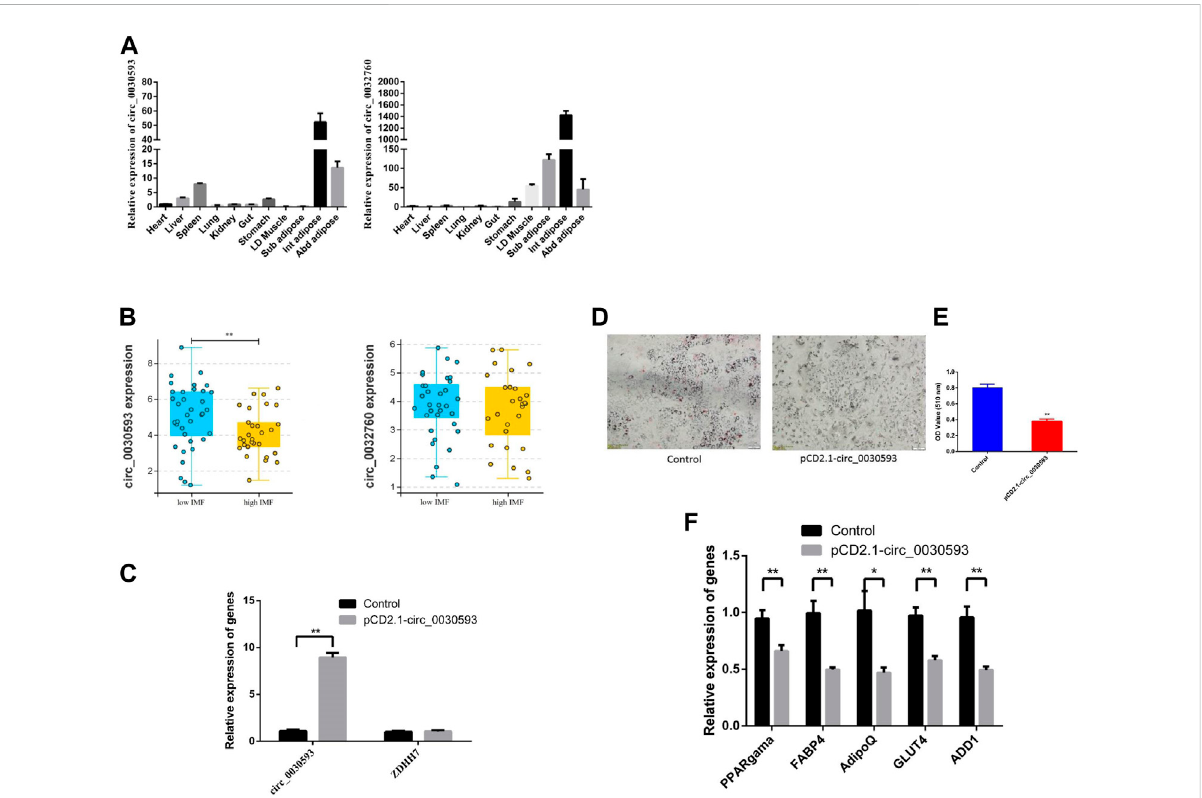
FIGURE 7 Function validation of differently expressed circRNAs (A) The expression level of circ_0030593 and circ_0032760 in different tissues by RT- qPCR. (B) circ_0030593 and circ_0032760 expression in longissimus dorsi muscle from high IMF and low IMF pigs (C) The effect of